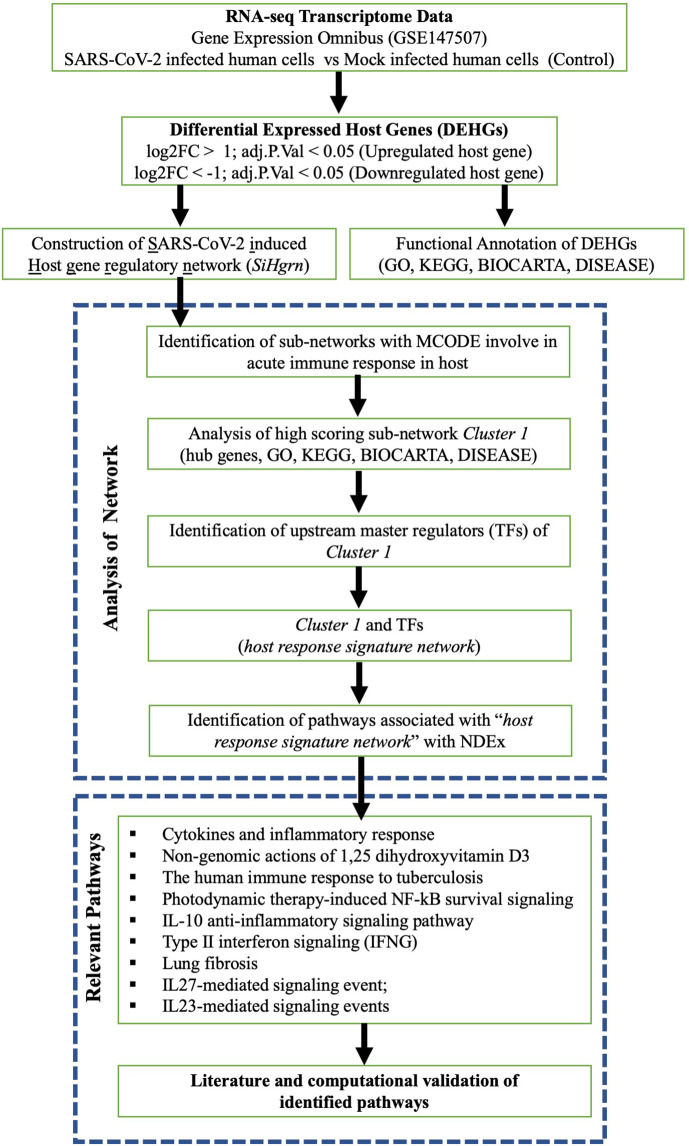
Schematic diagram of present study workflow.